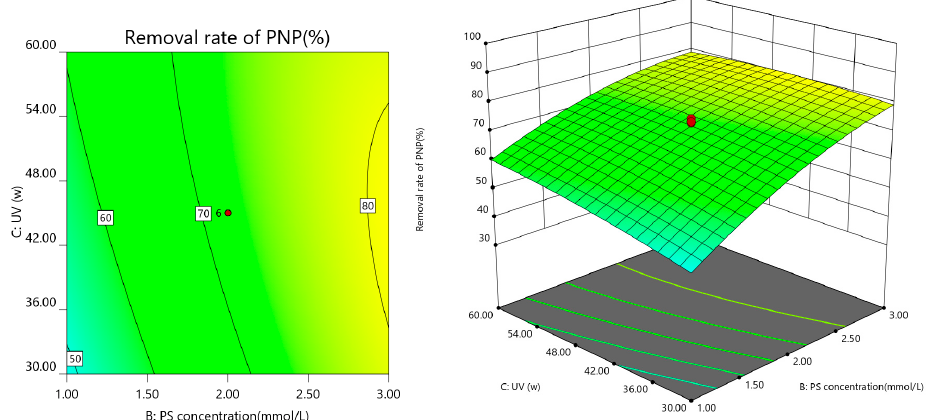
Figure 9. Response surface diagram of the relationship between PS concentration and UV power.